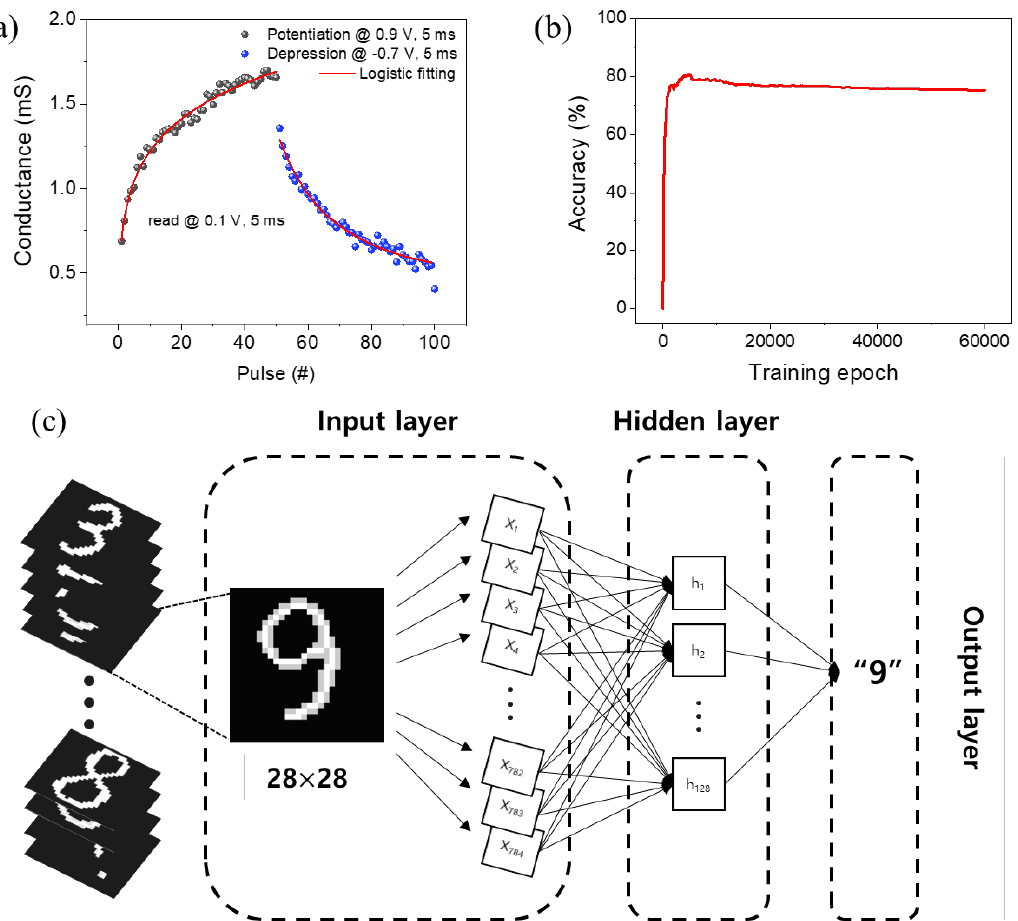
Figure 4. ( a ) Conductance with the potentiation and depression pulse of the Ag/SnO/TiN device. ( b ) Recognition accuracy of the MNIST. ( c ) Schematic of three-layer neural network for the neuromophic system.